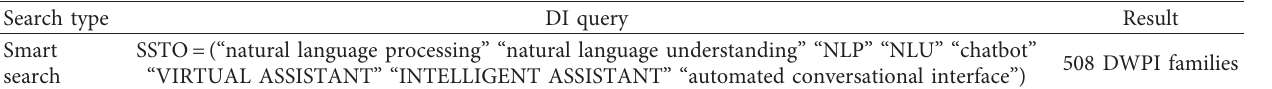
Table 2: Search query for